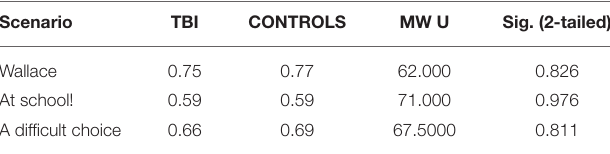
TABLE 5 | Actor studio: simple matching coefficients (moral emotions). Scenario